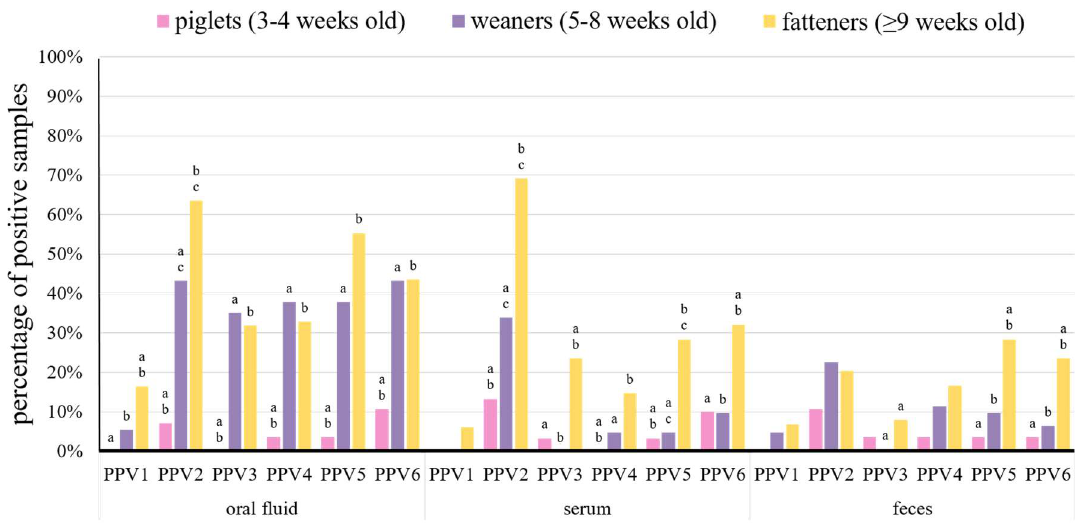
Figure 2. Percentage of porcine parvoviruses 1–6 (PPV1–PPV6) positive samples from piglets ( n = 86), weaners ( n = 161), and fatteners ( n = 405) in different diagnostic materials (oral fluid, serum, and feces). Statistically significant differences ( p < 0.05, Fisher’s exact test) between age groups in diagnostic materials, within bars grouped for each virus, are marked with superscripts on the top of bars in the chart (a, b, and c).